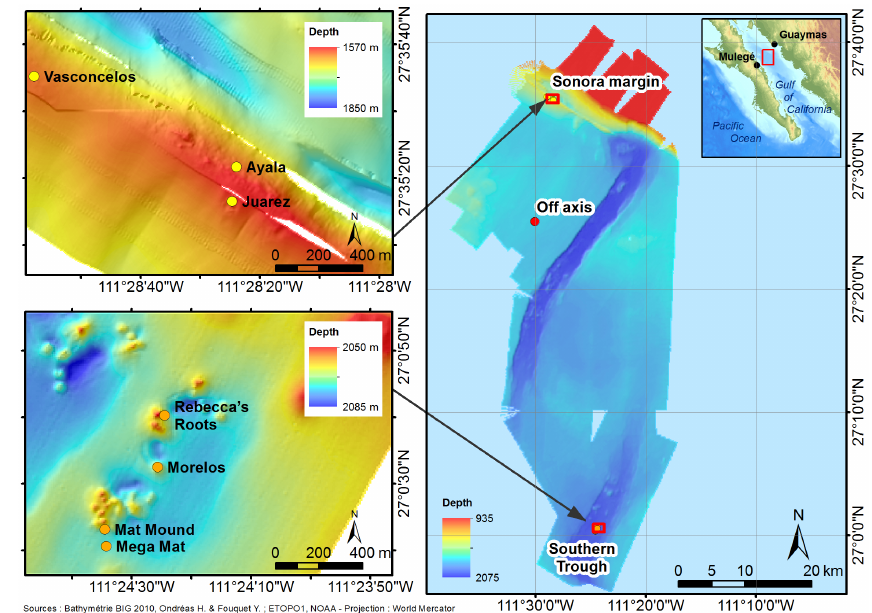
Figure 1. Localisation of the study sites on the Sonora margin cold seeps (Ayala, Vasconcelos and Juarez sites), the Southern Trough hydrothermal vents (Rebecca’s Roots, Mat Mound, Morelos and Mega Mat sites) and the Guaymas Basin off-axis reference